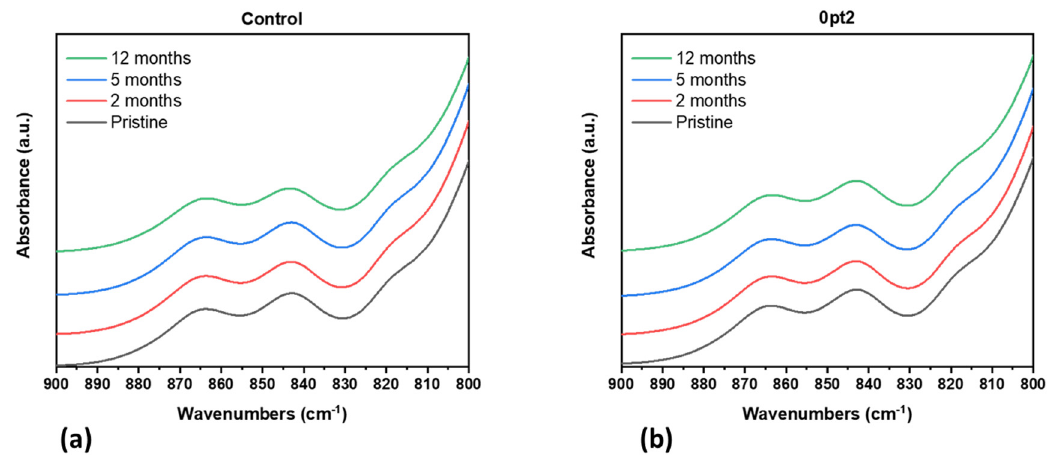
Figure A3. FTIR absorbance spectra of pristine and 50 °C aged samples showing peaks at 845 cm − 1 and 865 cm − 1 , which correspond to siloxanol groups (Si – OH): ( a ) Controls and ( b ) 0pt2.